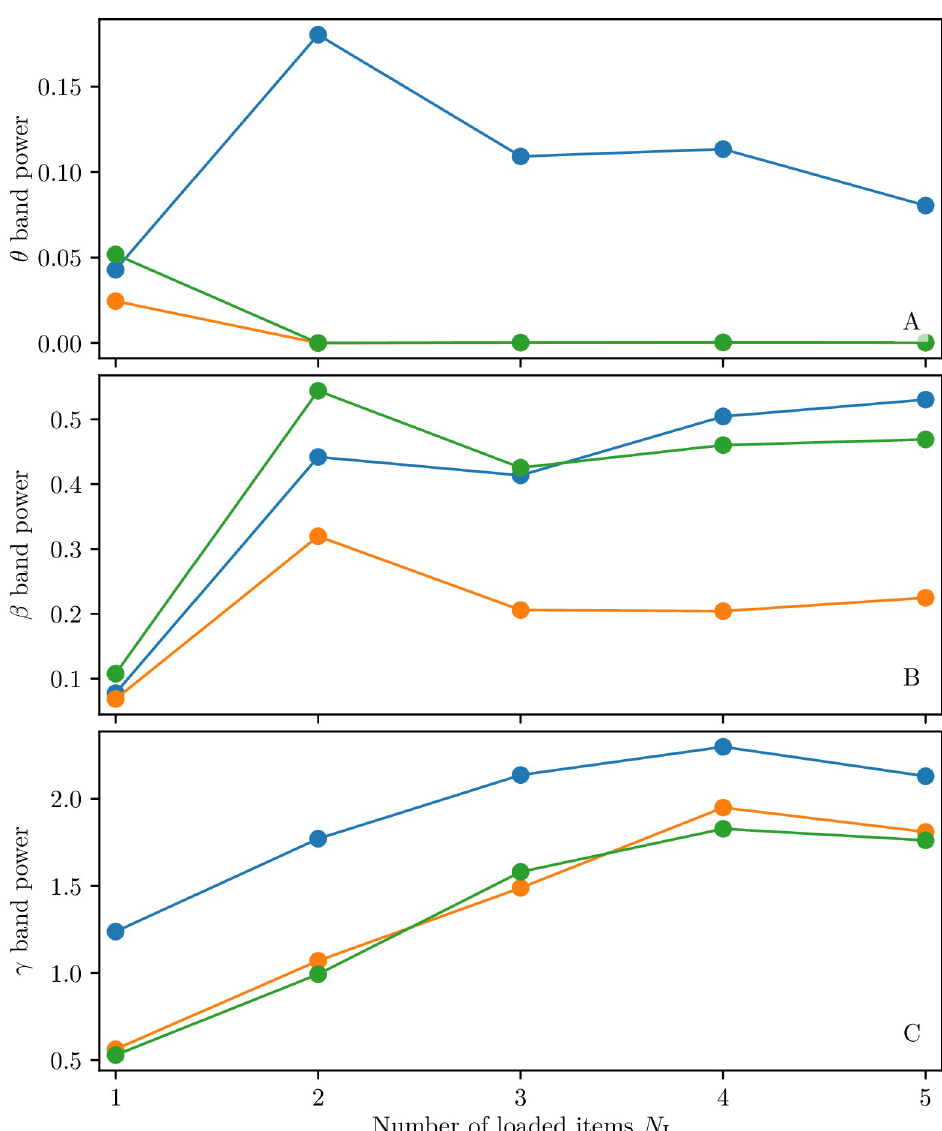
Fig 11. Dependence of the power on the number of loaded items. Power in the θ -band (3-11 Hz) ( A ), in the β -band (11-25 Hz) ( B ) and in the γ -band (25-100 Hz) ( C ) as a function of the number N L = N integral of the power spectra in the specified frequency bands are displayed for the mean membrane potential v 1 ( t ) of the excitatory population one (blue symbols), the mean membrane potential v 0 ( t ) of the inhibitory population (orange symbols) and the mean membrane potentials averaged over all the excitatory populations (green symbols). The power spectra have been evaluated over a 10 s time window, after the loading of N WM. Parameter values as in Fig